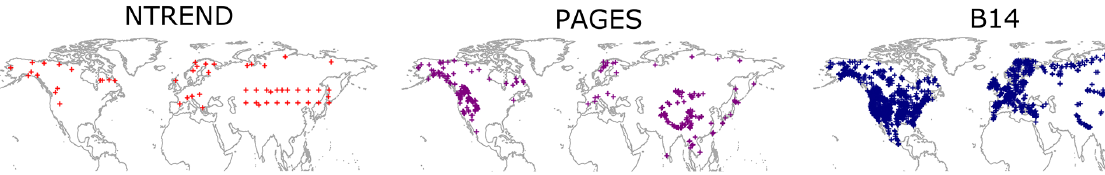
Figure 1. Proxy locations of the three collections.